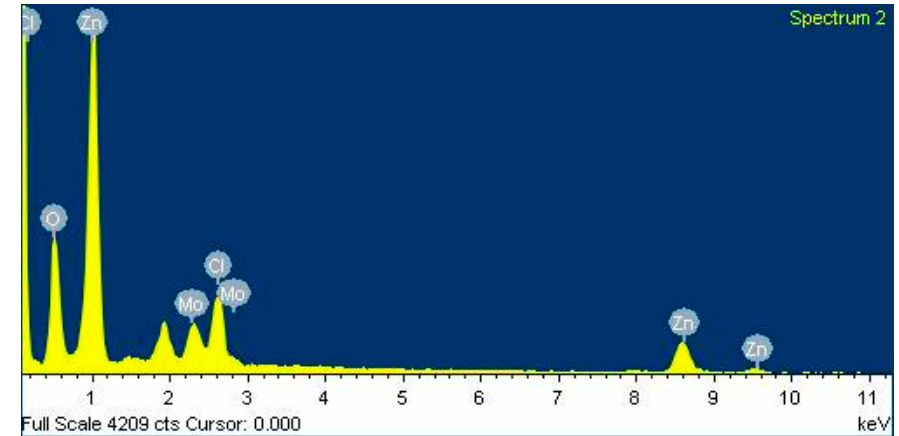
Figure 2. Energy dispersive x-ray analysis (EDX) spectrum of MoZnO. EDX spectrum displayed the atomic composition of MoZnO. The presence of Zn, Mo, O, and Cl elements were observed.